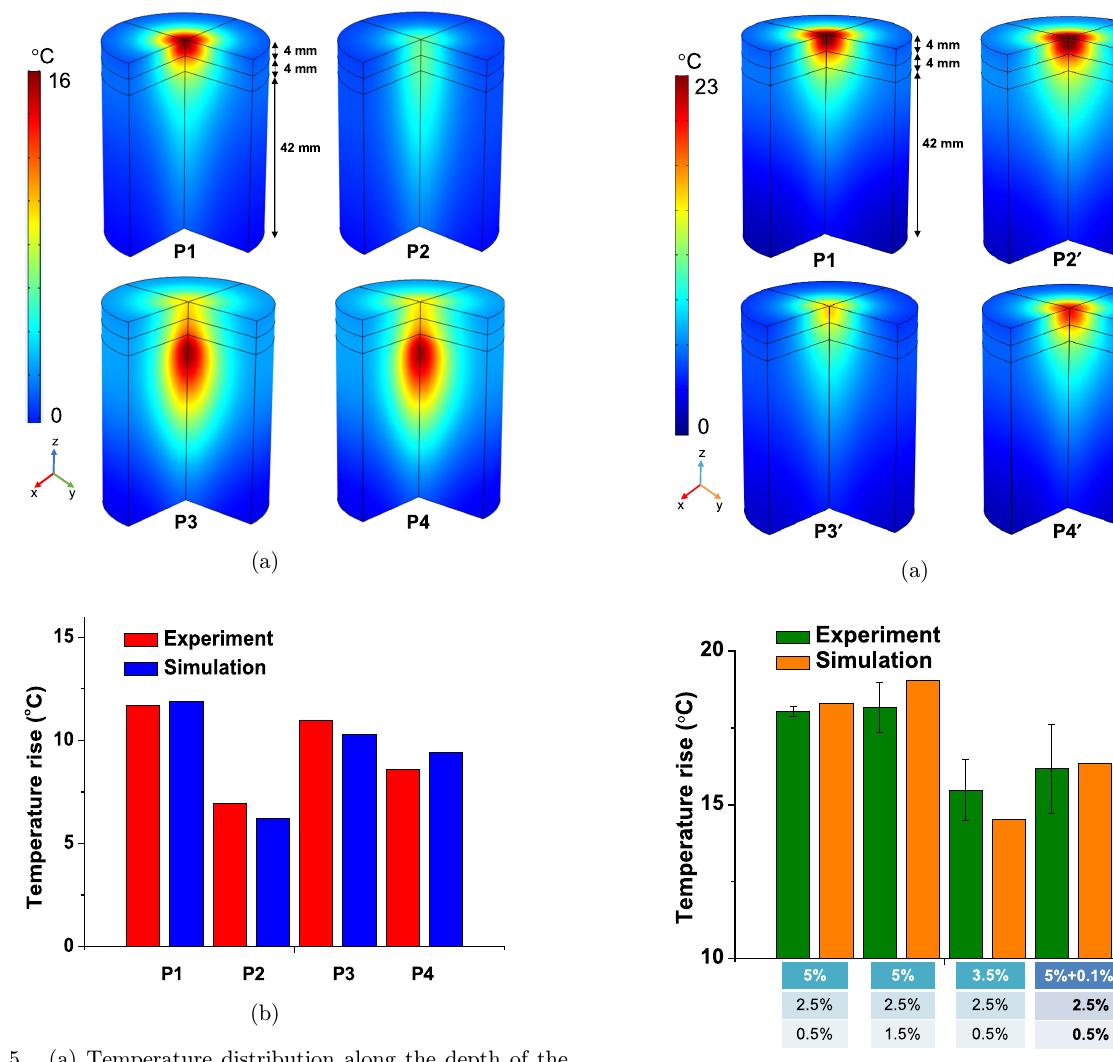
Fig. 5. (a) Temperature distribution along the depth of the three-quarter phantom with di®erent concentration of agar with 0.1% ink after 30 min and (b) Comparison of temperature variations from experiment and simulation occurring 4 mm below the surface of phantoms with di®erent compositions of agar gel layers after 30 min. Fig. 6. (a) Temperature distribution along the depth of the